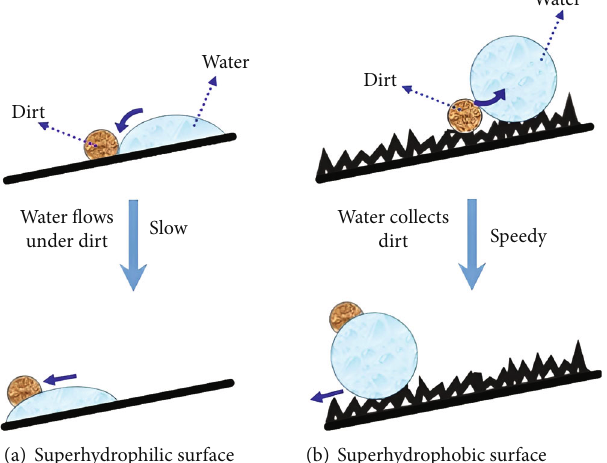
Figure 13: The schematic representation of the self-cleaning process in super-hydrophobic and super-hydrophilic surfaces